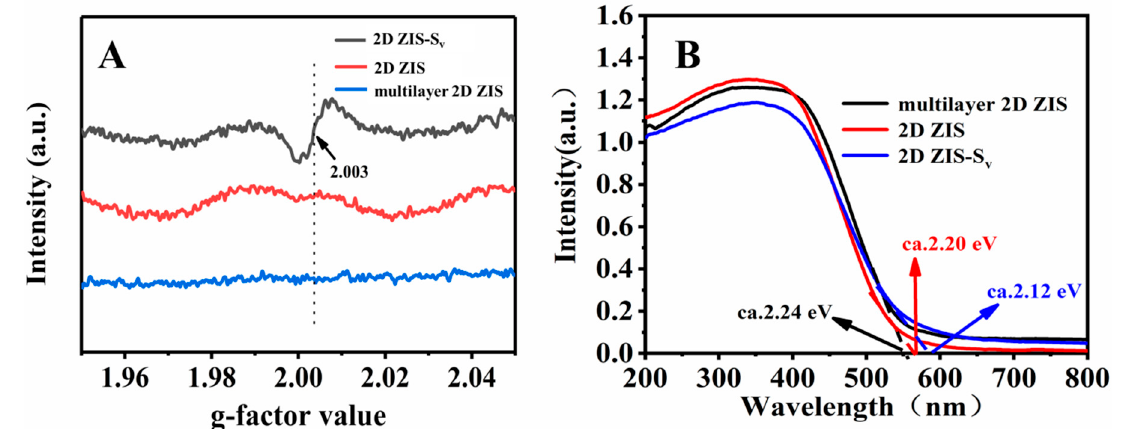
Figure 3. EPR (A) and UV ‐ vis DRS (B) of 2D ZIS, 2D ZIS ‐ S v , and multilayer 2D ZIS. Figure 3. EPR ( A ) and UV-vis DRS ( B ) of 2D ZIS, 2D ZIS-S v , and multilayer 2D ZIS.